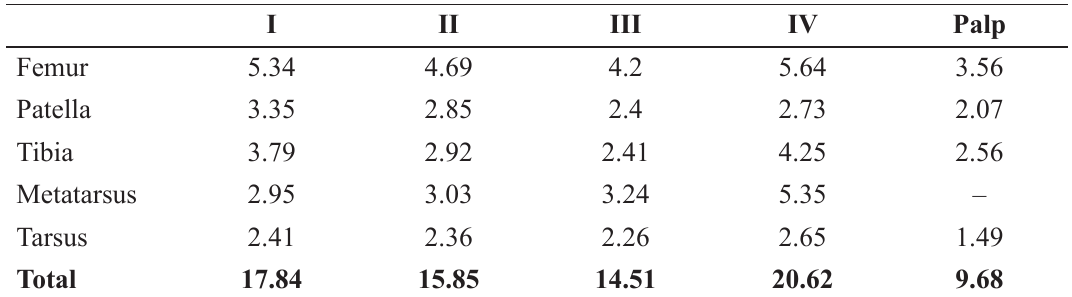
Table 7. Length of legs and palpal segments of holotype, ♂ (MPEG 7363) of Schismatothele wayana sp. nov.